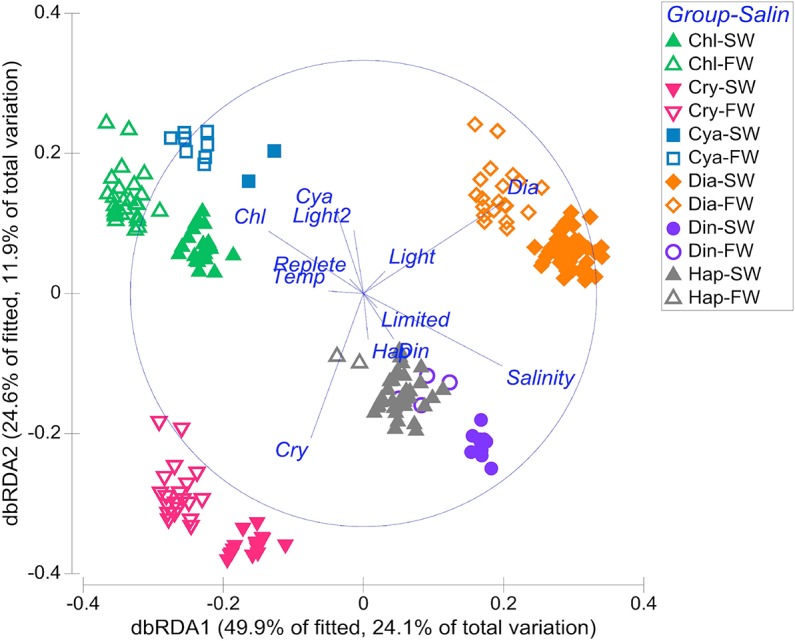
Distance-based redundancy analysis (dbRDA) ordination of the full multivariate ISTLM.The DISTLM partitioned the variance in phytoplankton fatty acids explained by the predictor variables for all 621 phytoplankton % FA profiles for which all culture conditions were available [follows Table 1 variable descriptions except salinity here is coded as freshwater (FW) or saline water (SW) for visualization)]. The group abbreviations are: Chl (Chlorophyta); Cry (Cryptophyta); Cya (Cyanobacteria); Dia [diatoms (Bacillariophyceae, Coscinodiscophyceae, Fragilariophyceae)]; Din (Dinophyta); and Hap (Haptophyta). The first two axes explained 75% of the variability in the fitted model. The top two ranked variables in the model for this dataset, group and salinity, are identified with the symbols. Vector overlays show the strength of the relationship between the predictor variables and the dbRDA axes.